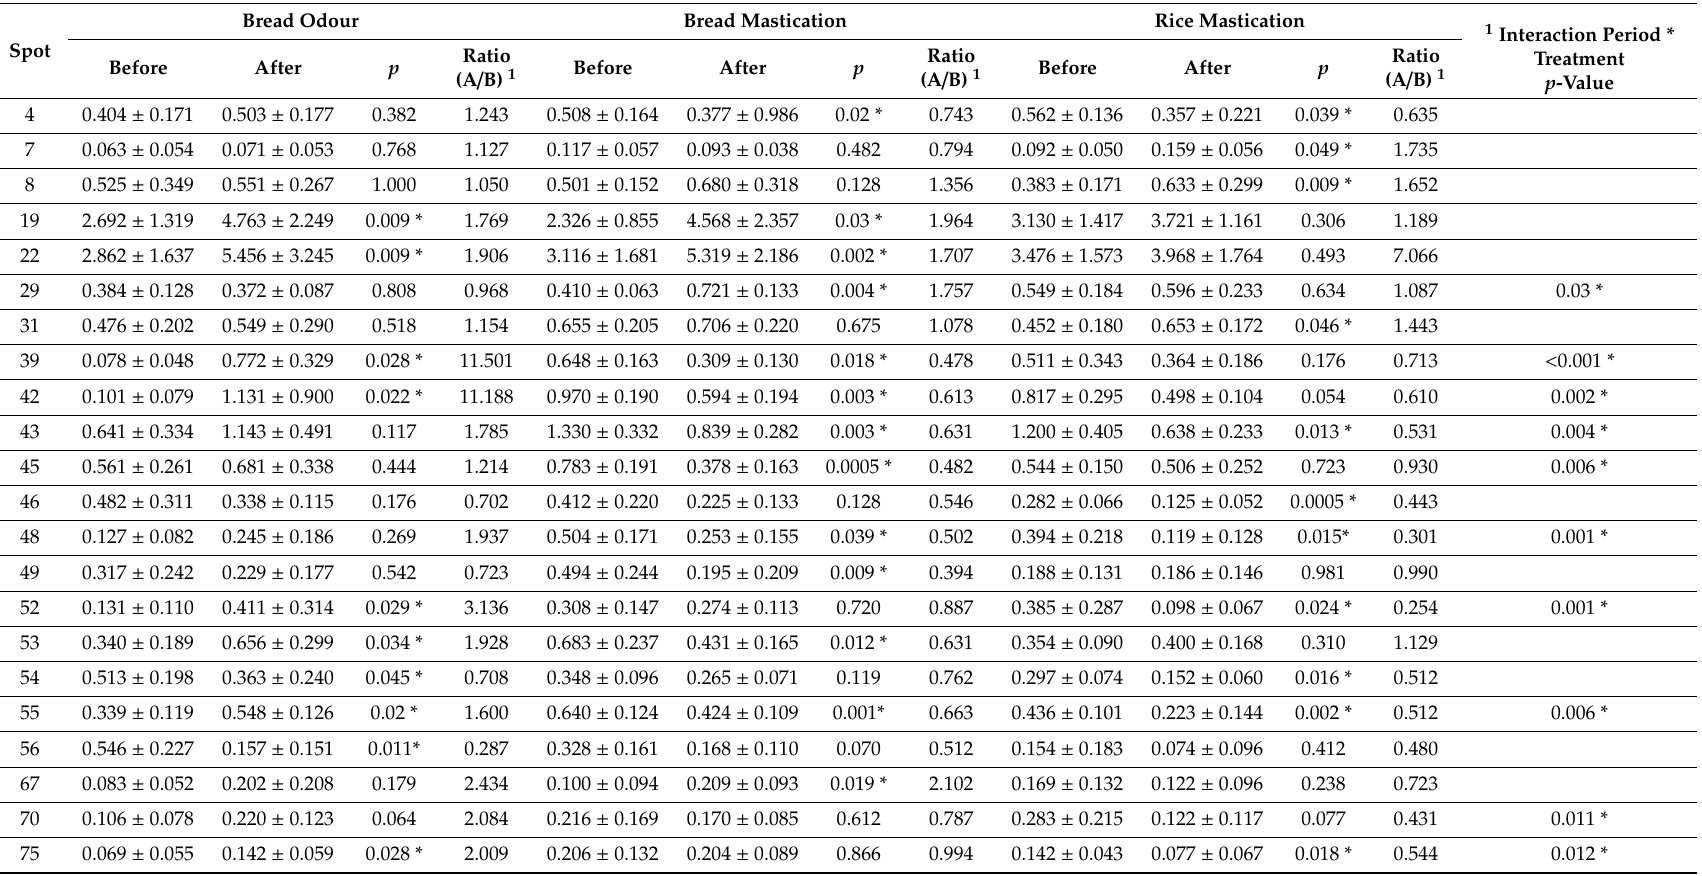
Table 3. Protein spots significantly changed by the di ff erent stimuli (values are mean ± standard error of %